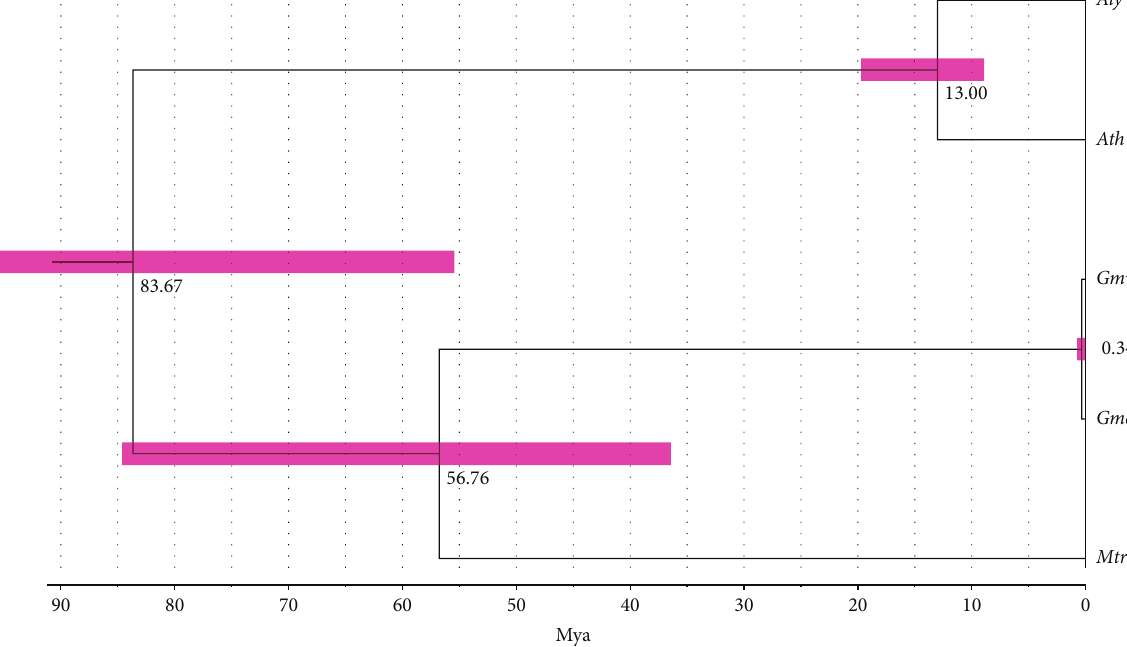
Figure 1: Phylogenetic tree of G. max cv. Williams 82 ( Gmw ), G. max cv. Enrei ( Gme ), A. thaliana ( Ath ), A. lyrata ( Aly ), and M. truncatula ( Mtr ). The pink bar represents the 95% probability density. Mya represents a unit in million